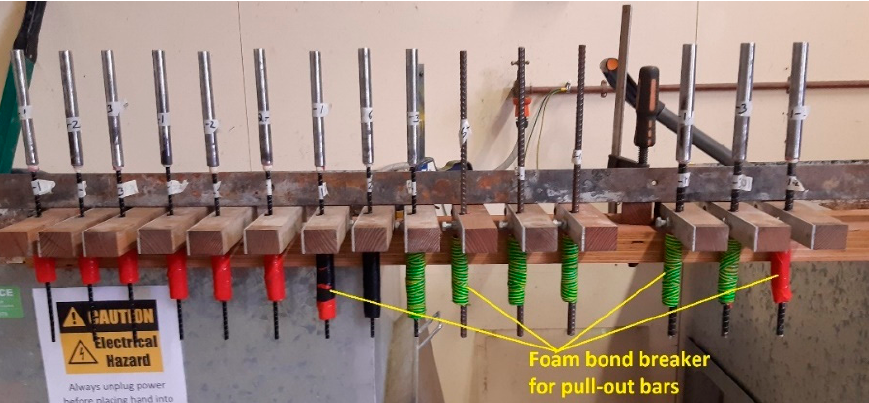
Figure 4 . Pull-out bars taped with bond breaker foams before casting. A day before casting, the steel cubic moulds were cleaned, and a natural release agent called LanoForm was applied. Later, the prepared basalt FRP and steel bars were placed at the bottom of the mould and clamped on either side of the mould to prevent slippage from the centre of the mould. On the day of casting, the freshly prepared SCGC was poured, with the pull-out bars in the centre of the mould (Figure